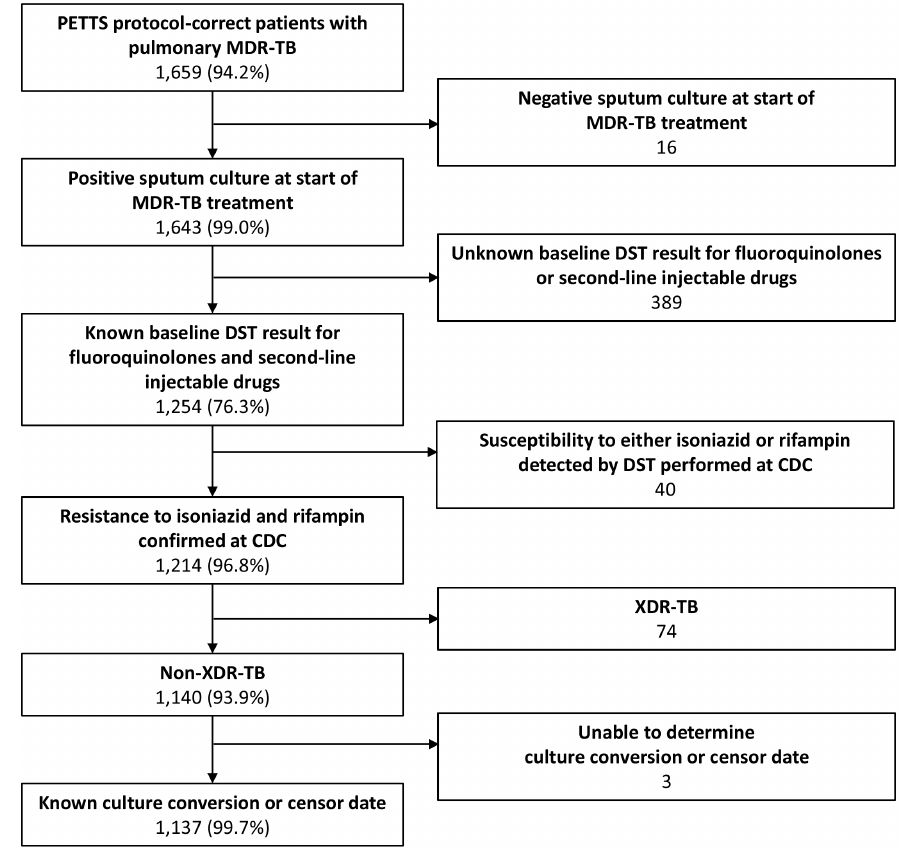
Fig 1. Inclusion of patients in the analysis. MDR-TB is tuberculosis resistant to at least isoniazid and rifampin; XDR-TB is tuberculosis resistant to at least isoniazid, rifampin, one fluoroquinolone, and one second-line injectable